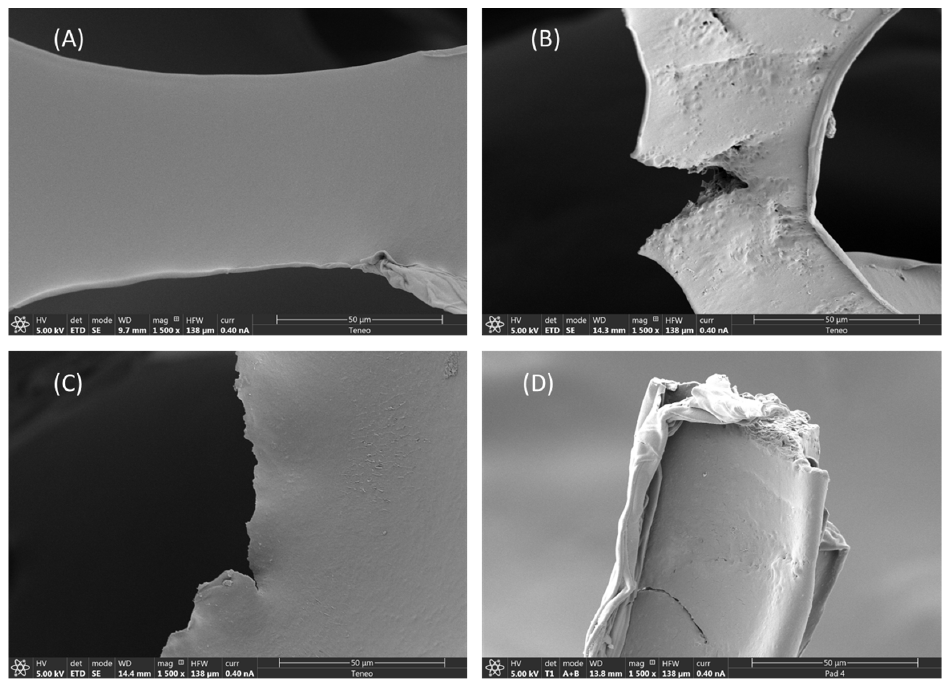
Figure 3 . Scanning Electron Microphotography (SEM) of different PU foams: PU-virgin ( A) ; PU after Figure 3. Scanning Electron Microphotography (SEM) of different PU foams: PU-virgin ( A ); PU after 10 days ( B) ; PU after 17 days ( C , D) . 10 days ( B ); PU after 17 days ( C , D